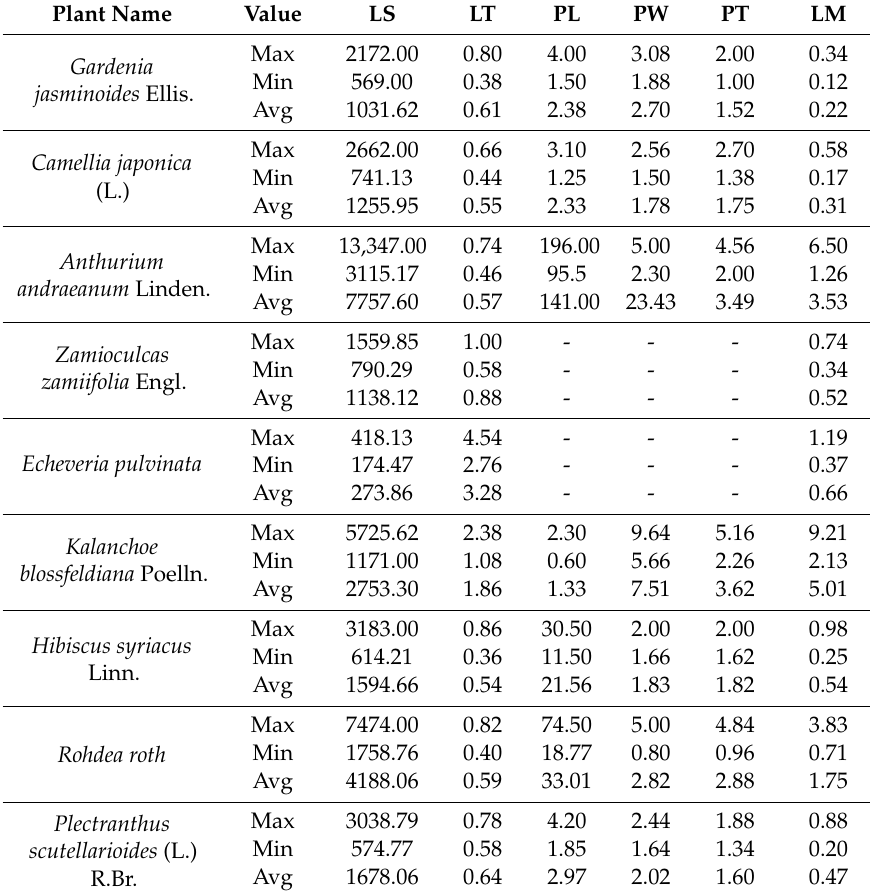
Table 1. Plant leaf physical